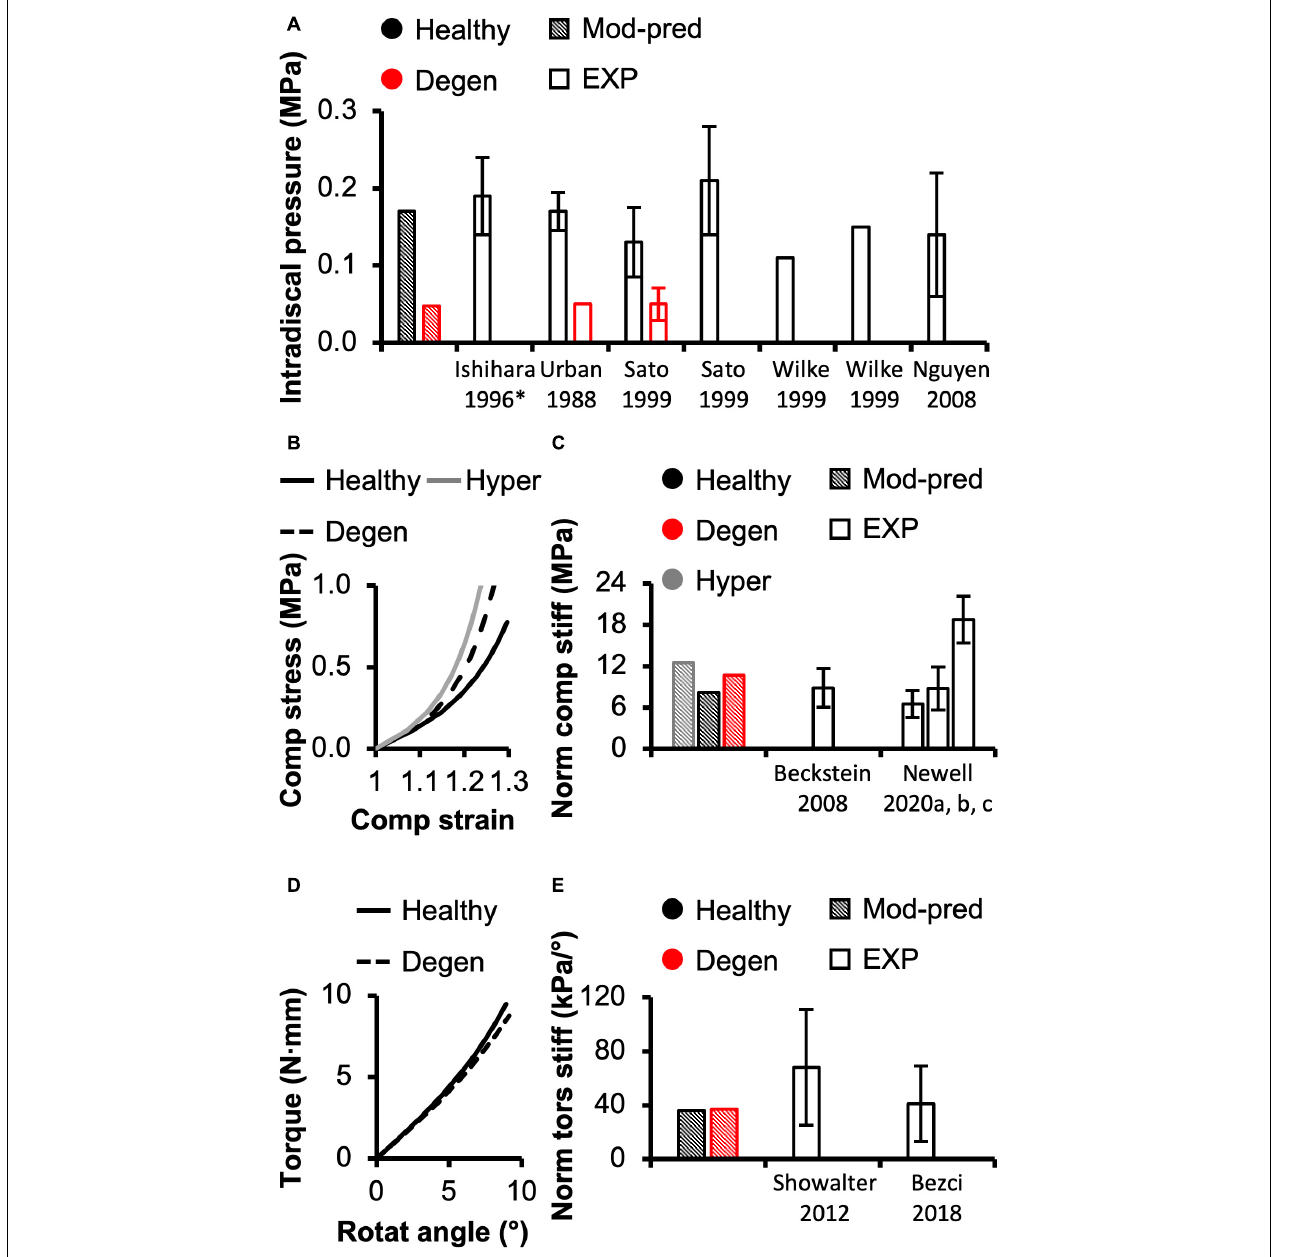
FIGURE 3 | (A) Model-predicted (Mod-pred) resting intradiscal pressure in healthy and degenerated (Degen) disc models compared to experimental (EXP) values. Data reported by Ishihara et al. (1996) (noted by * ) were obtained from bovine caudal discs while data reported by the other listed studies were obtained from human intervertebral discs, which have shown to share comparable intradiscal pressure values. Variations were not reported in Wilke et al. (1999). (B) Representative model-predicted compressive (Comp) stress-strain response of hyperelastic (Hyper), healthy, and degenerated disc models under axial compression. (C) Model-predicted normalized (Norm) compressive stiffness (stiff) compared to EXP values. (D) Representative model-predicted torsional (tors) response of healthy and degenerated discs when evaluated for torsional mechanics. (E) Model-predicted normalized torsional stiffness compared to EXP values.